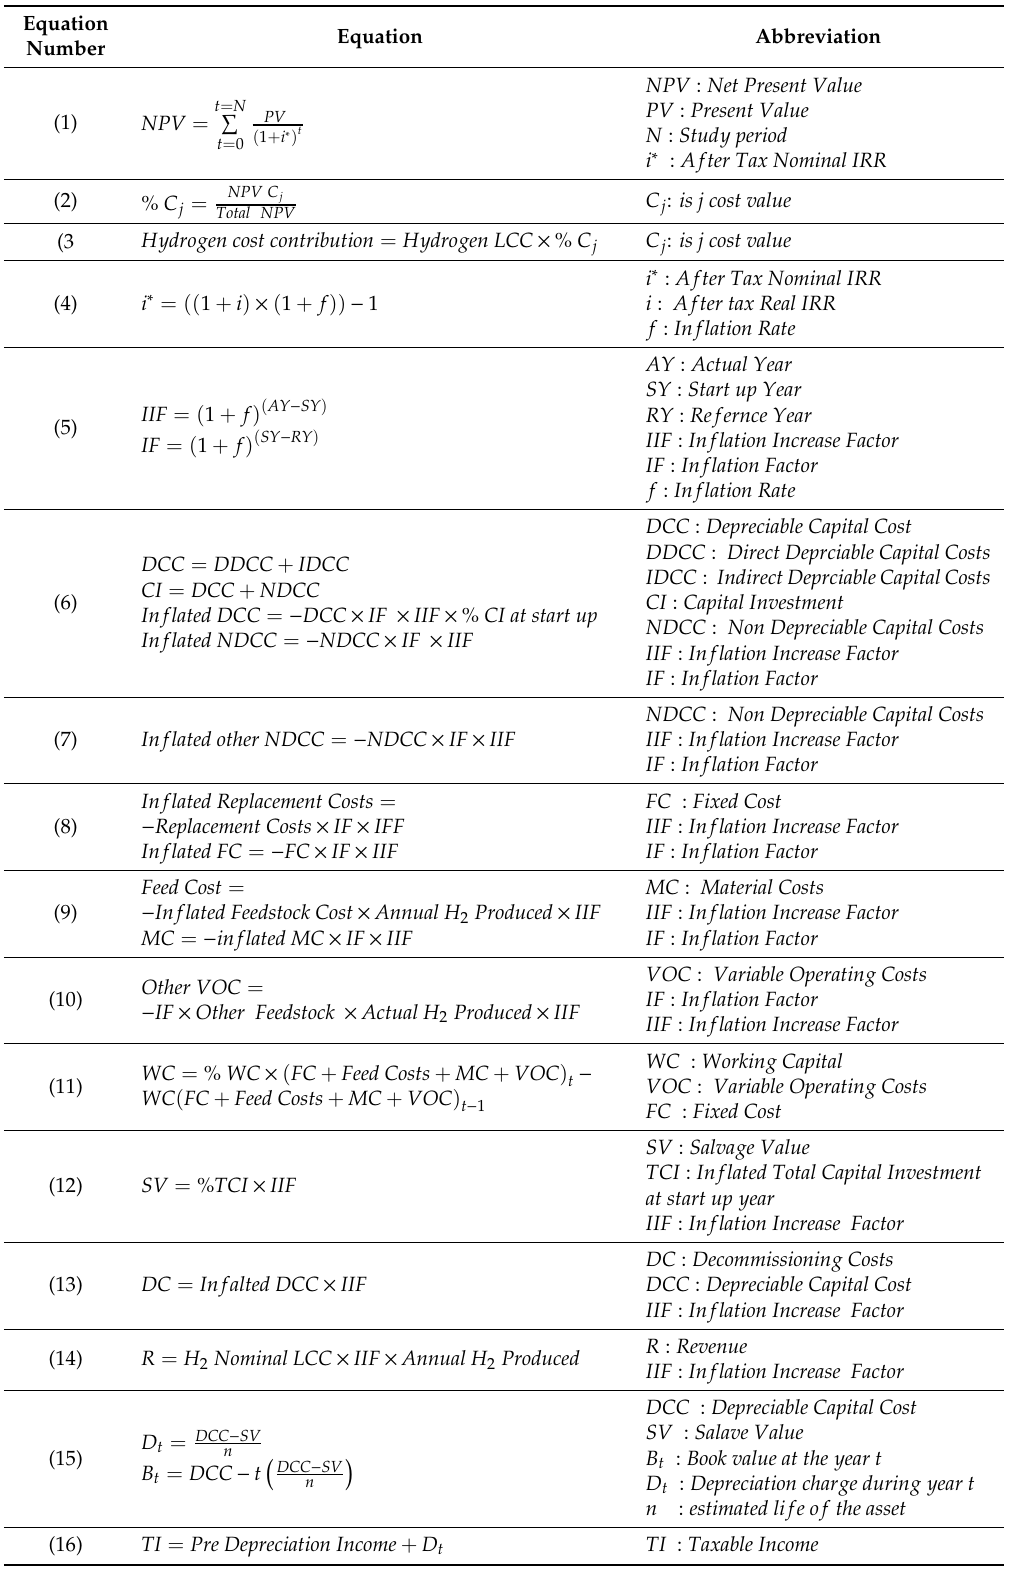
Table 3. Economic analysis equations used for life cycle